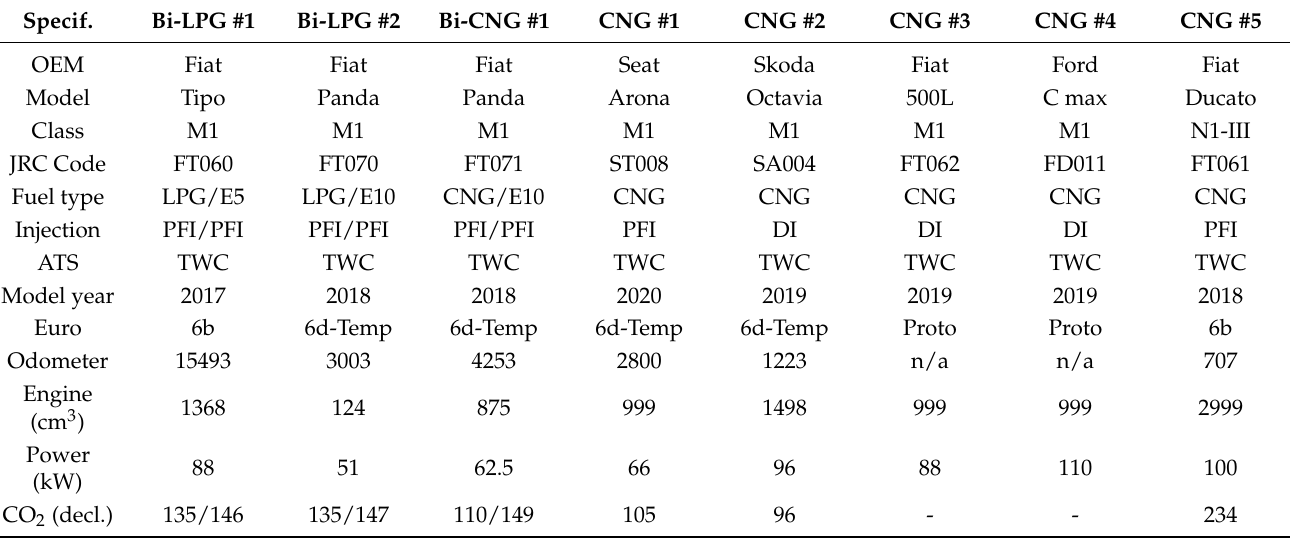
Table 5. Vehicles